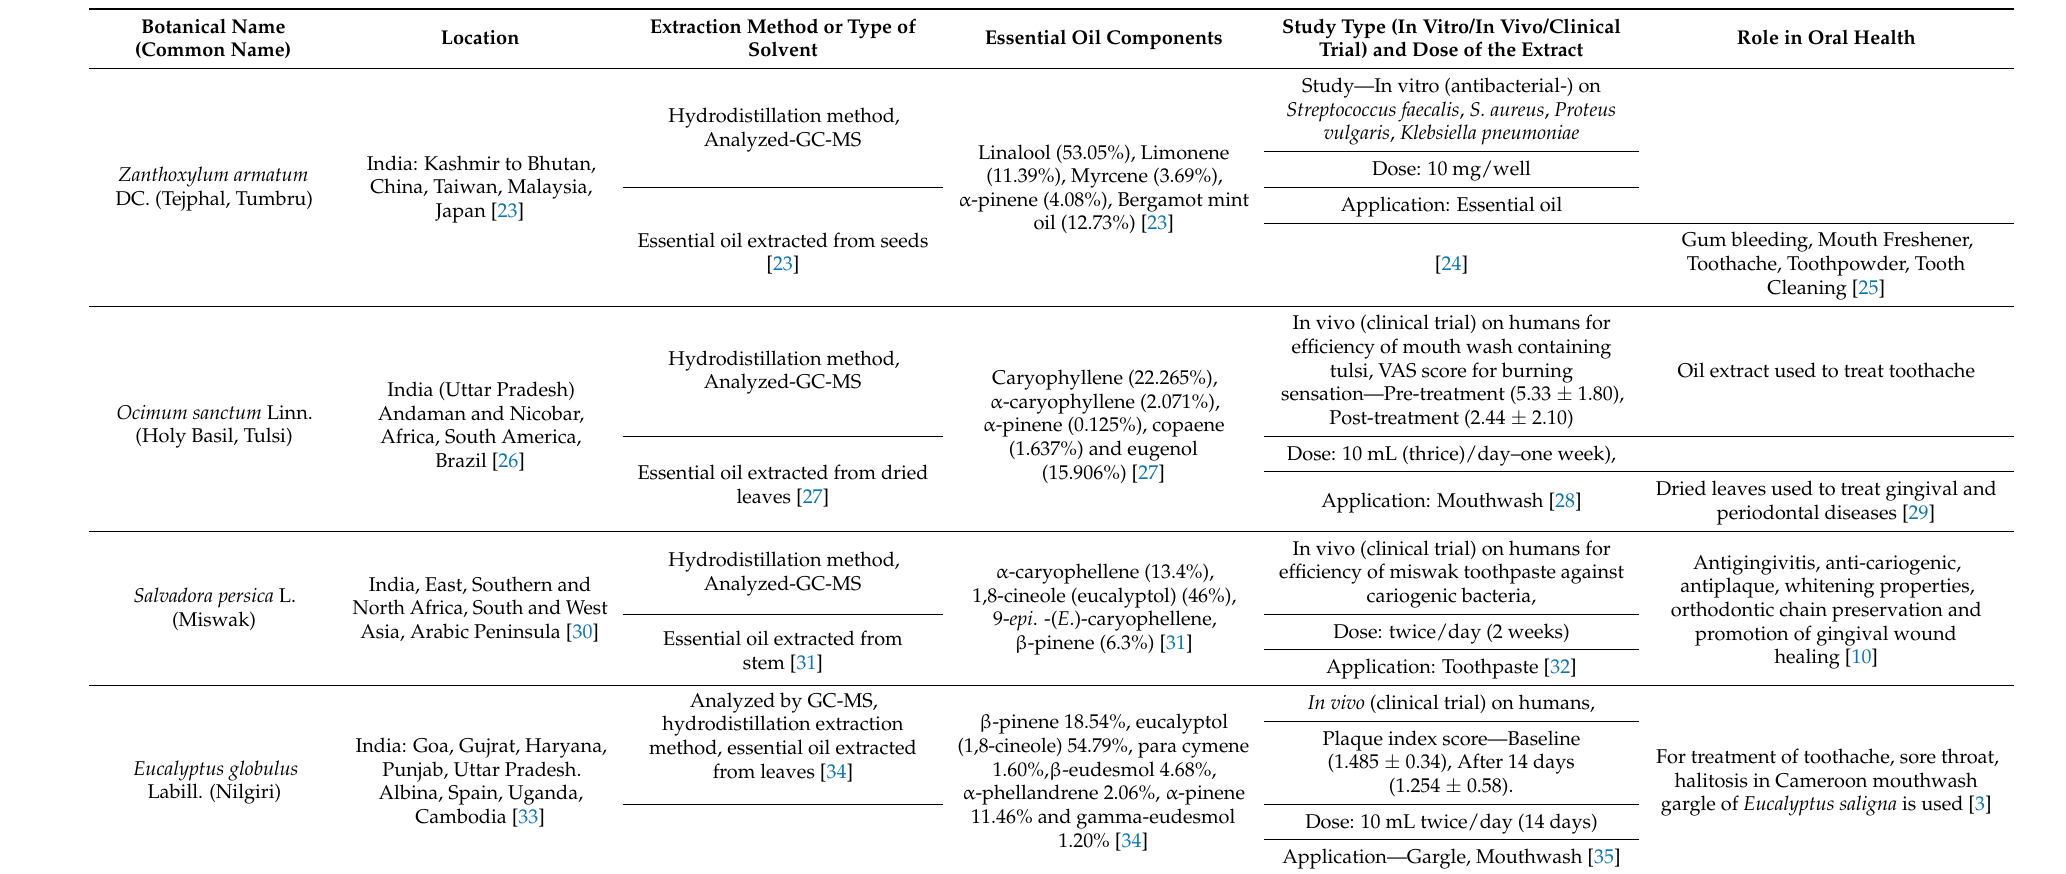
Table 2. Medicinal plants useful in oral